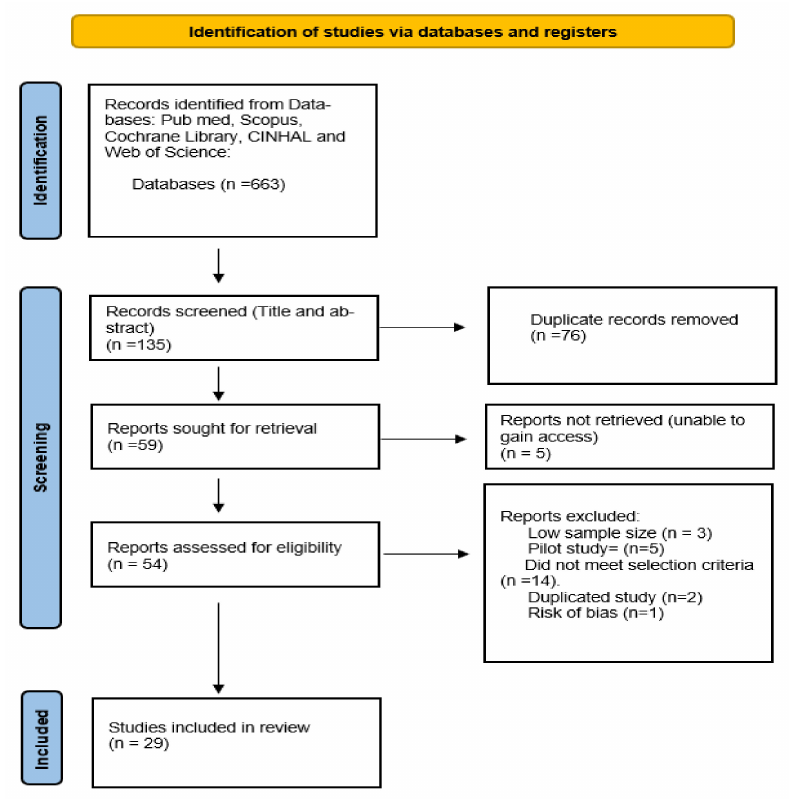
Figure 1. PRISMA flow diagram.